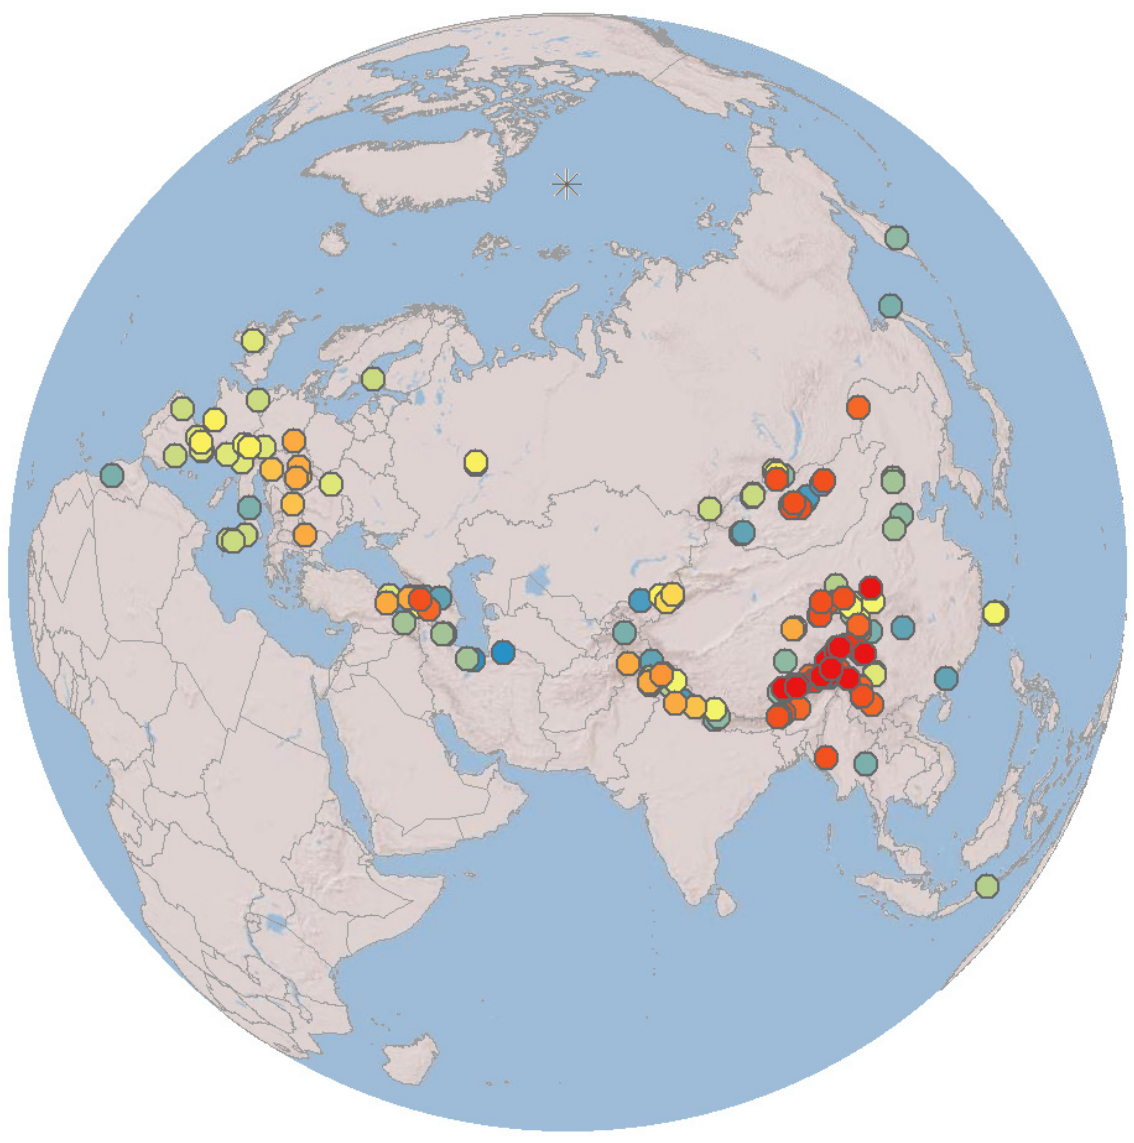
Fig. 7. Sample sites for barcodes for the subgenus Melanobombus von Dalla Torre, 1880, colour-coded for the order in which the samples of selected barcoded individuals were added to the analyses, from blue (2011) to red (2019) (specimens may be much older). Spherical projection with the North Pole shown as a star, international boundaries as recognized by the UN shown as grey lines. Map projected in ArcGIS using the World_Shaded_Relief basemap © 2014